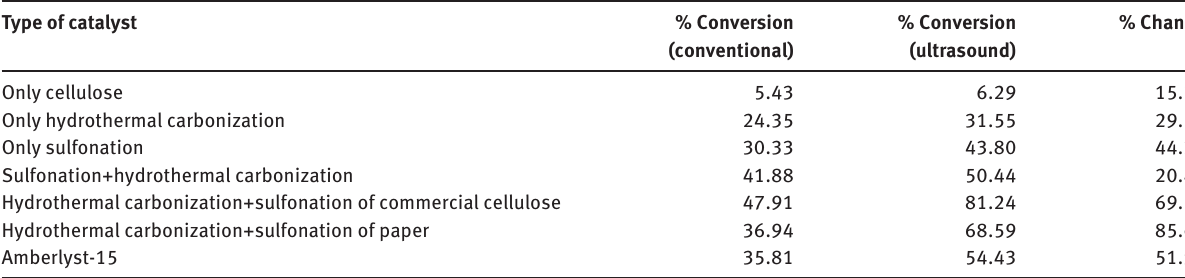
Table 1 Comparison of the efficacy of various catalysts in terms of the extent of the conversion for the conventional and ultrasound assisted approach.